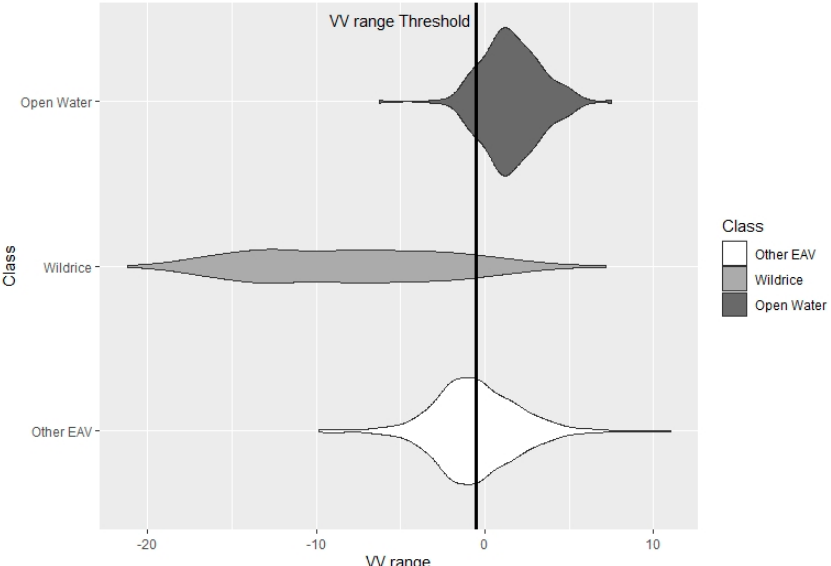
Figure 4. The frequency and distribution of Vertical Vertical (VV) range values for 333 wildrice presence, 333 other emergent aquatic vegetation (absence), and 200 open water samples were used to determine the optimal threshold for presence samples. A threshold of − 0.5 was selected, which corresponds with the median value of absence points, to eliminate other taxa present in mixed stands of wildrice and isolate the signature of wildrice.